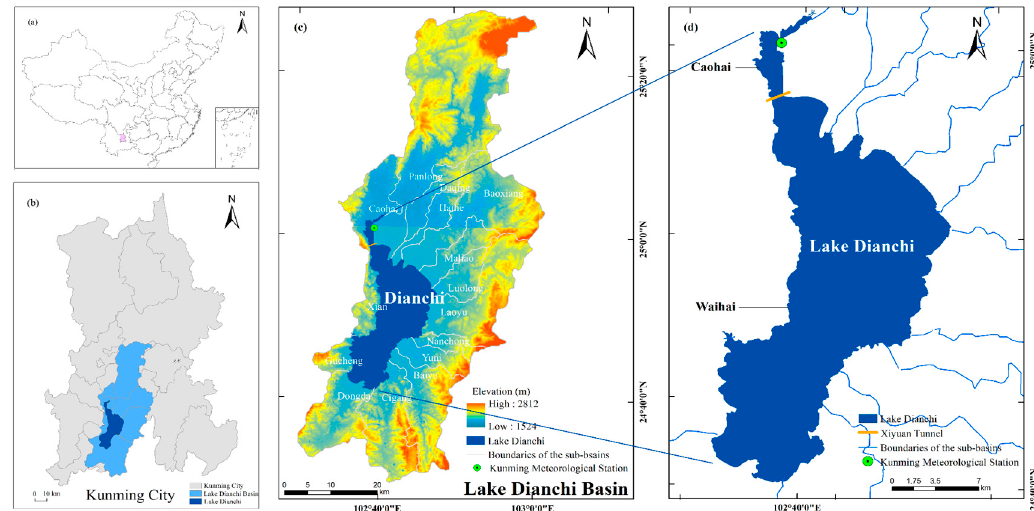
Figure 1. Location of Lake Dianchi, China. ( a ) Location of Lake Dianchi Basin in China; ( b ) distribution of the water body and Lake Dianchi Basin in Kunming City; ( c ) distribution of the water body in the basin; and ( d ) Lake Dianchi.